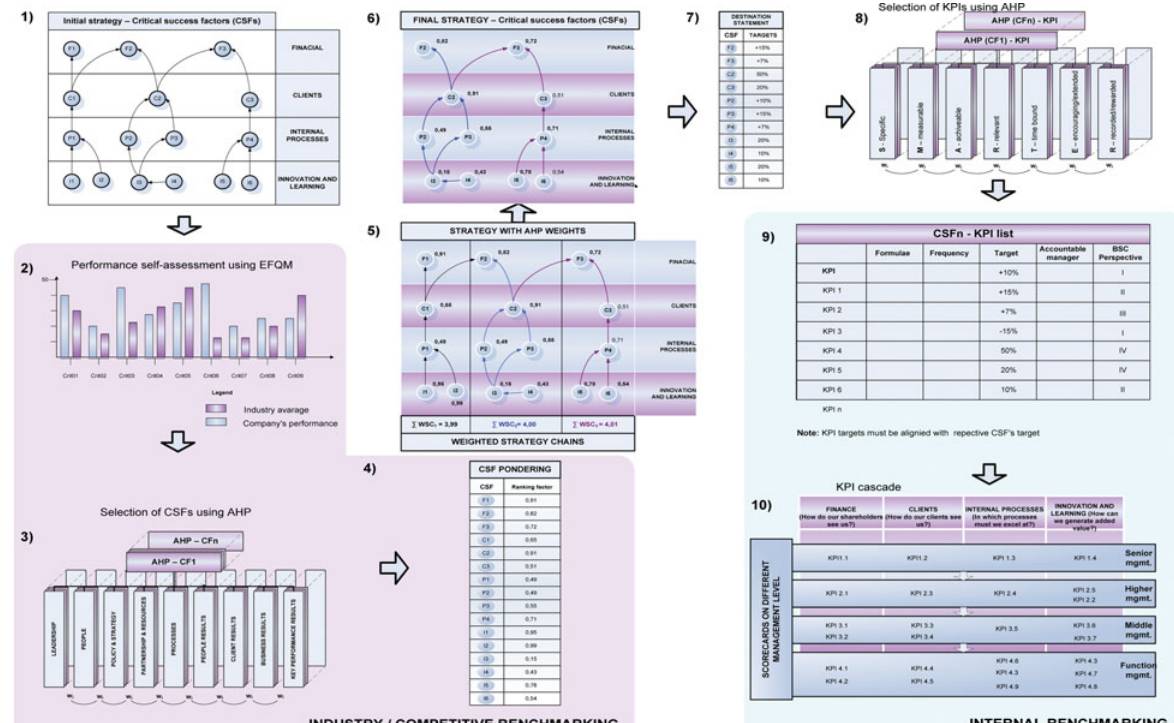
Fig. 4. The verification of the framework through 10